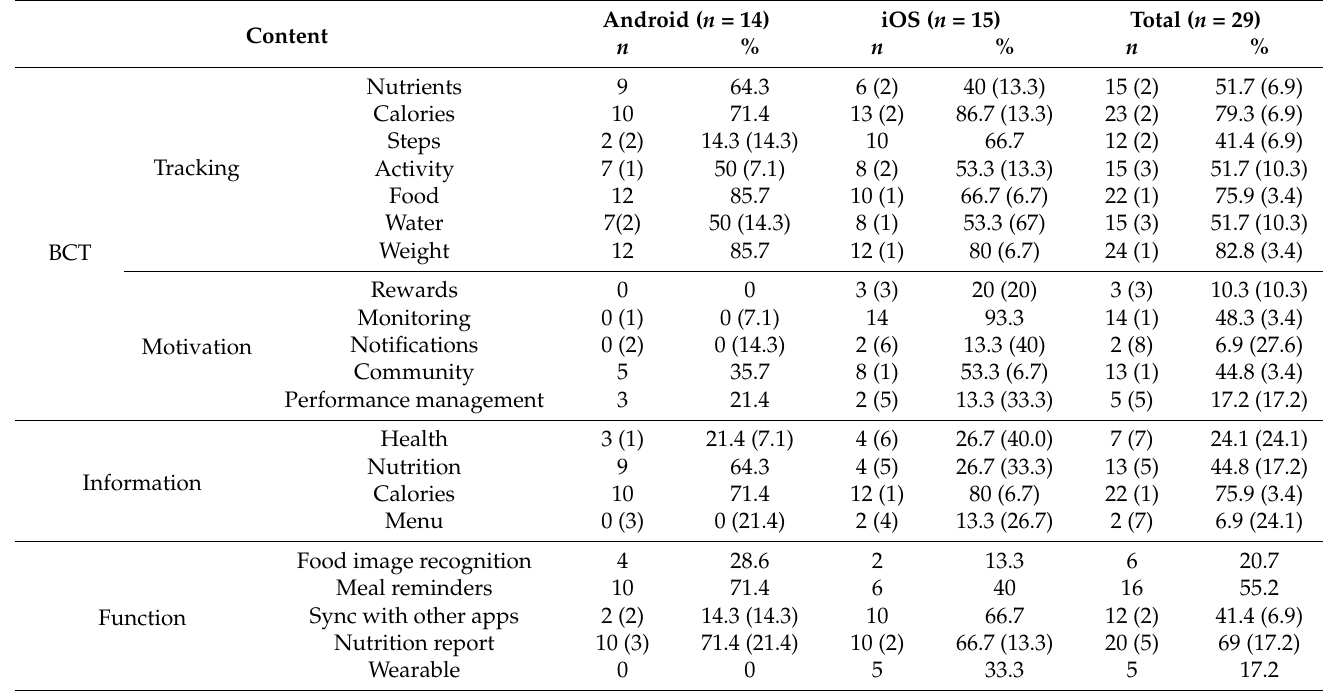
Table 1. Content analyses of the 29 dietary mobile